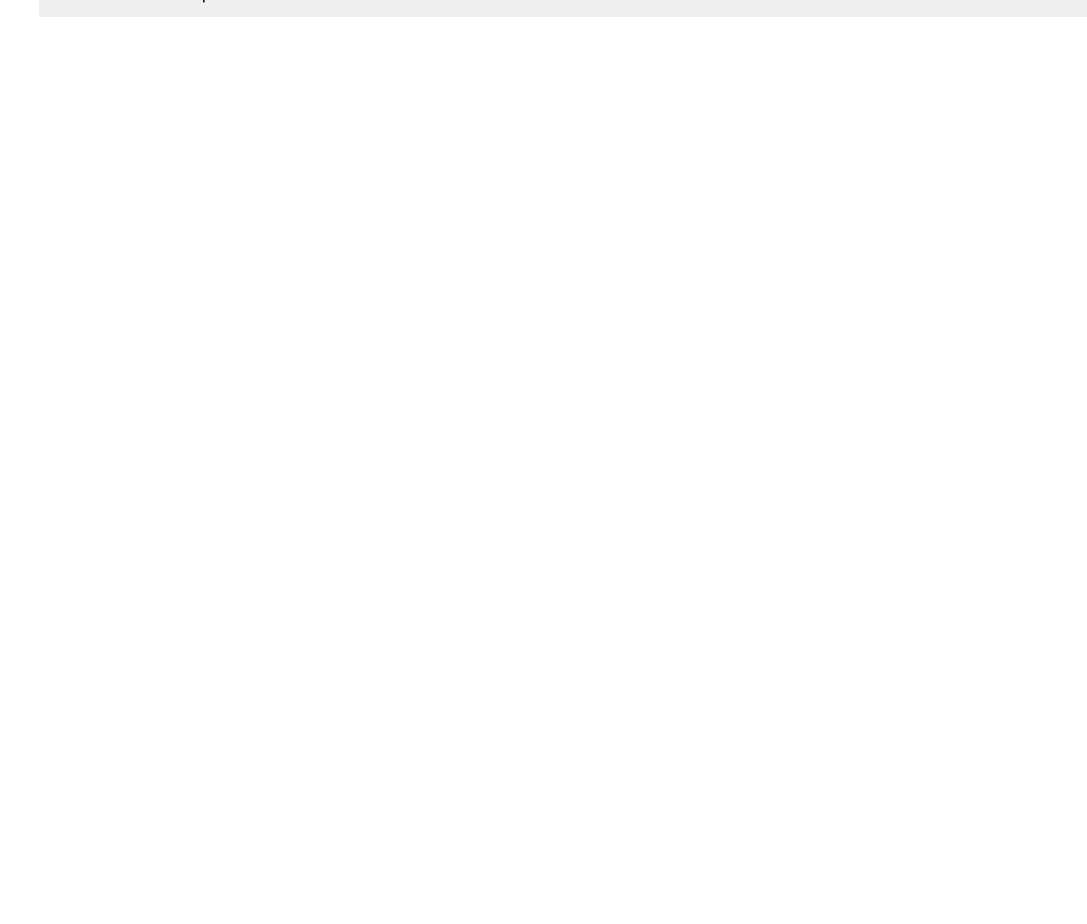
Figure 1 EQ-5D health